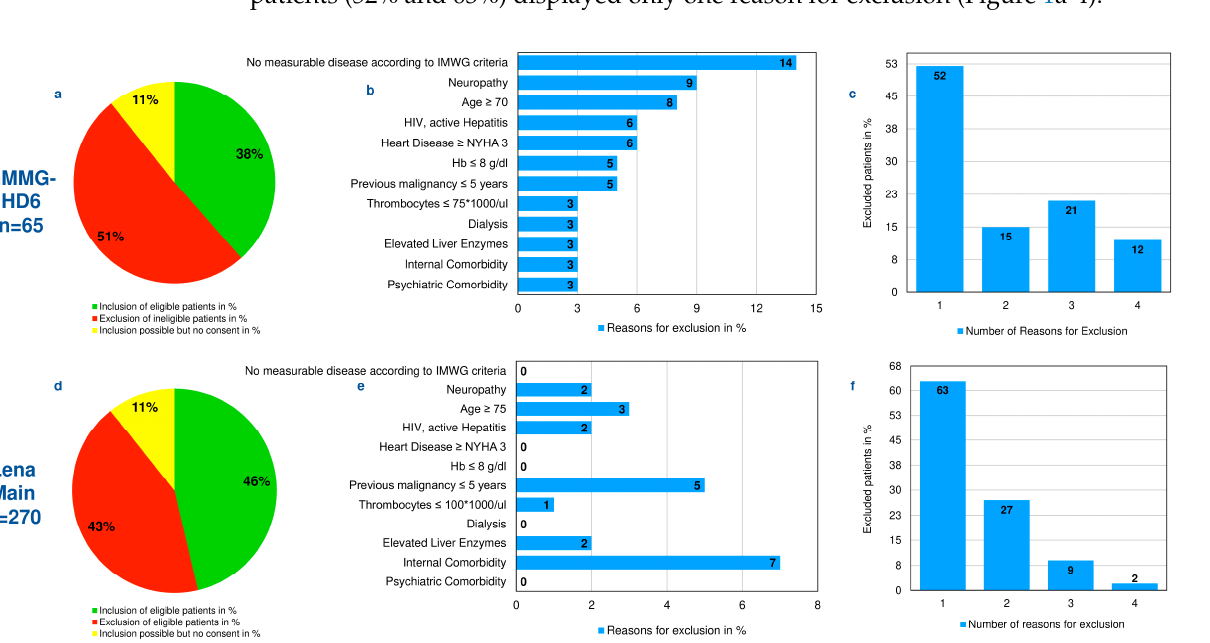
Figure 1. First-line trials, HD6 and LenaMain. ( a , d ) Patients included, excluded, and inclusion possible but no consent given by the patient. ( b , e ) Reasons for exclusion, in %. ( c , f ) Number of reasons for exclusion, in %.